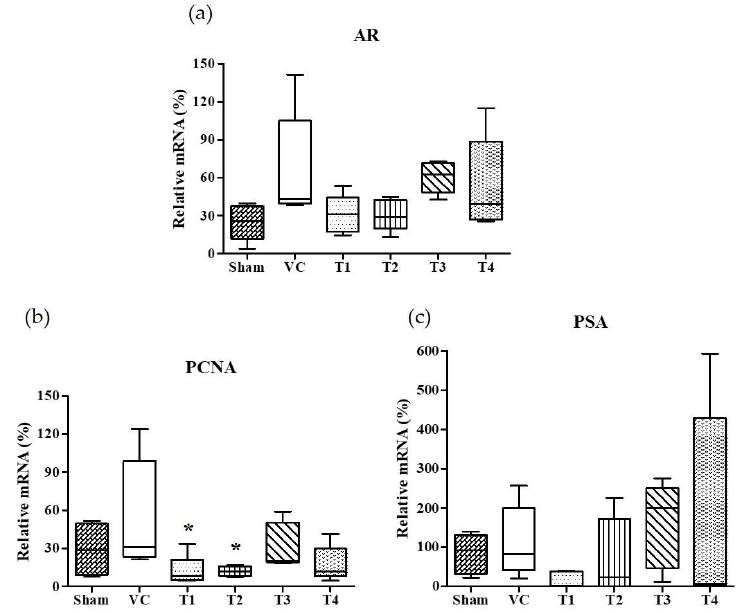
Figure 3. E ff ects of orally administered A. melanocarpa extracts T1~T4 on androgen receptor (AR), prostate specific antigen (PSA), and proliferating cell nuclear antigen (PCNA) protein expressions in the ventral prostate tissues of testosterone propionate-treated Wistar rats. AR mRNA expressions ( a ), PSA mRNA expressions ( b ), and PCNA mRNA expressions ( c ). Results were expressed as the mean value ( ± SD) of animals in each groups. * p < 0.05 vs. the VC group. The preparation and administration of T1~T4 are described in Materials and